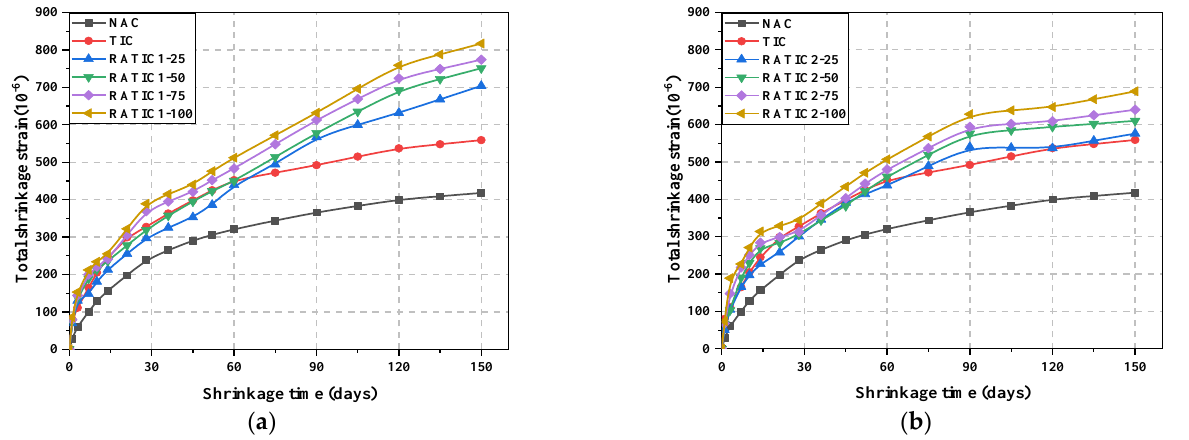
Figure 8. The total shrinkage curve of RATIC with time: ( a ) RATIC1; ( b ) RATIC2.